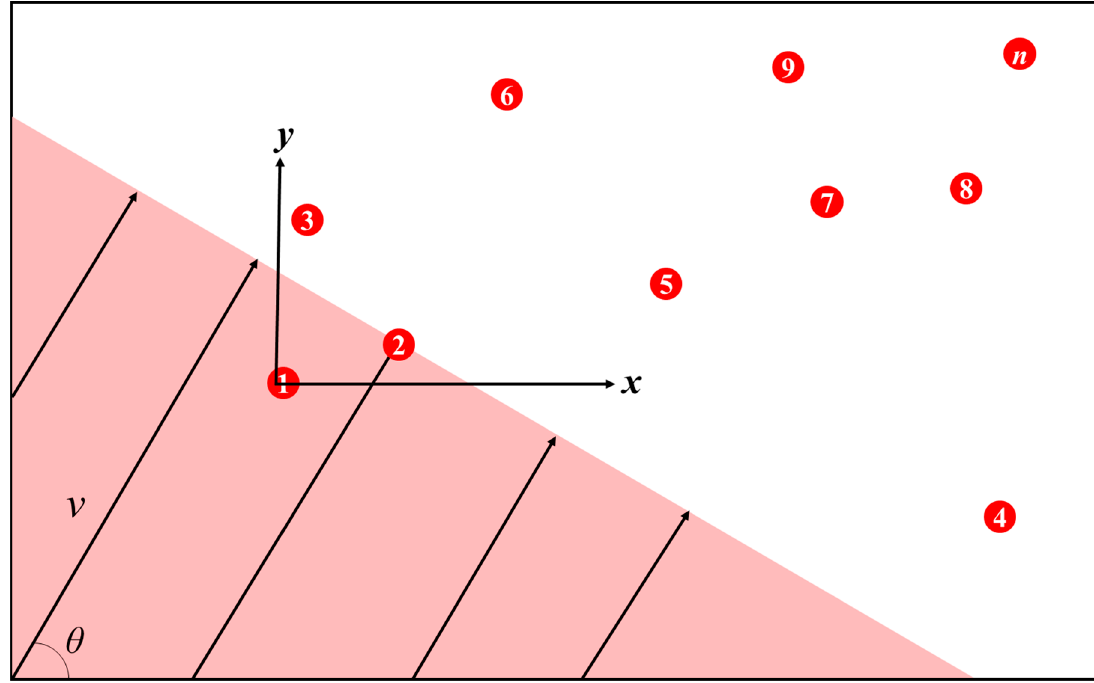
Figure 16. Illustration for the algorithm of the time difference of PWV arrival for determining the movement of a typhoon when the typhoon is approaching GNSS stations in the rectangle coordinate system defined in this study.